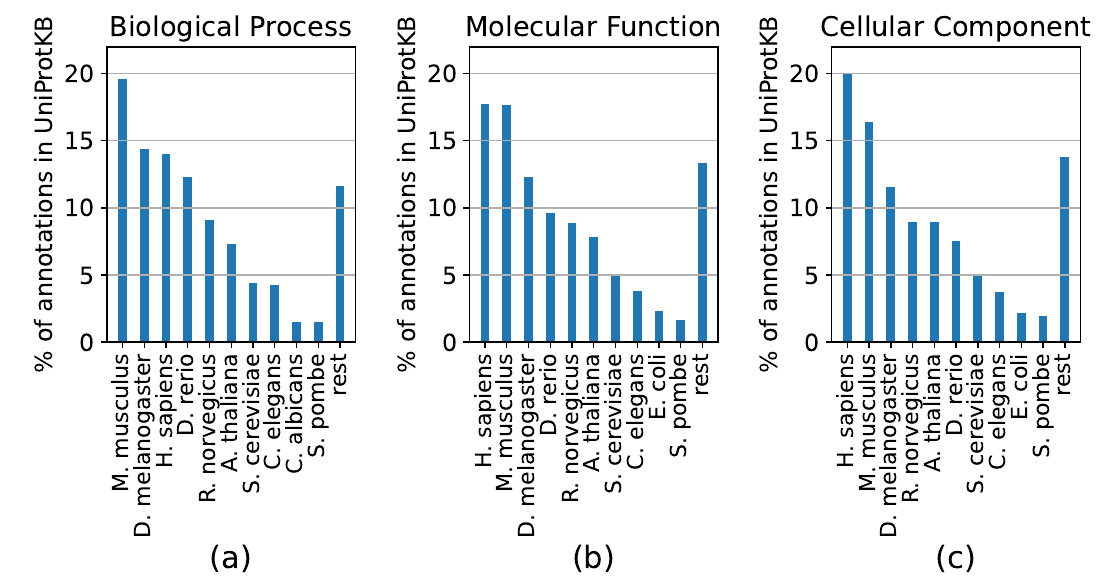
Figure 2. Distribution of experimental annotations from the Biological Process ( a ), Molecular Function ( b ) and Cellular Component ( c ) ontologies per species for proteins in UniProtKB. The ten species with the most annotations are shown for each ontology and annotations for all other species are shown in the ‘rest’